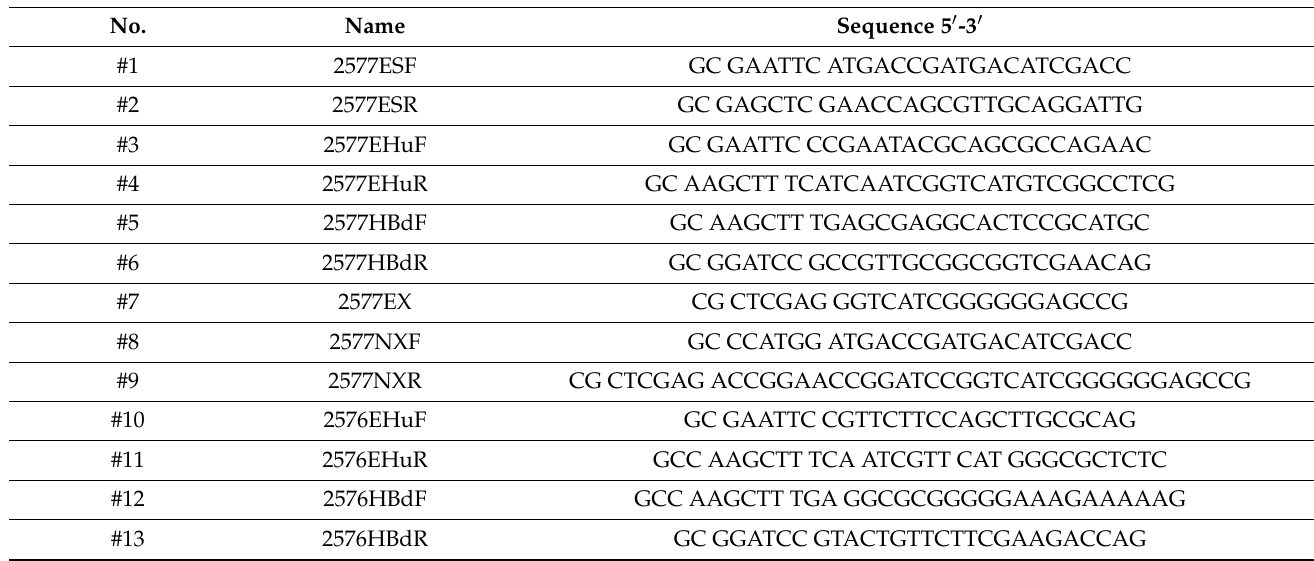
Table A2. List of primers used in this